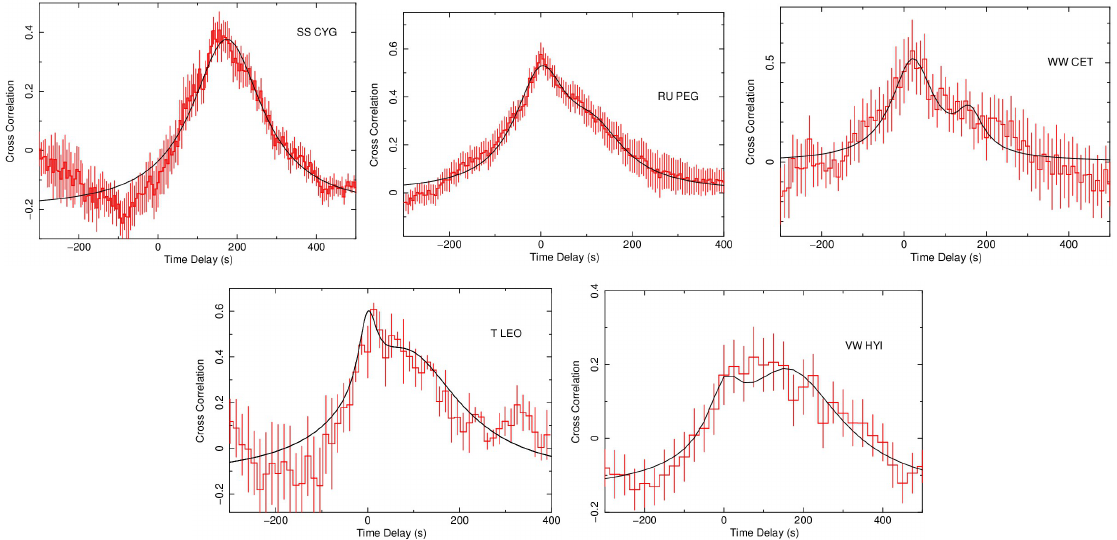
Figure 3: See Figure 10 in Balman & Revnivtsev (2012). The cross-correlation of the EPIC pn (X-ray) and OM (UV) light curves with 1 sec time resolution. The two-component Lorenzian fits are shown as solid black lines (except for SS Cyg).